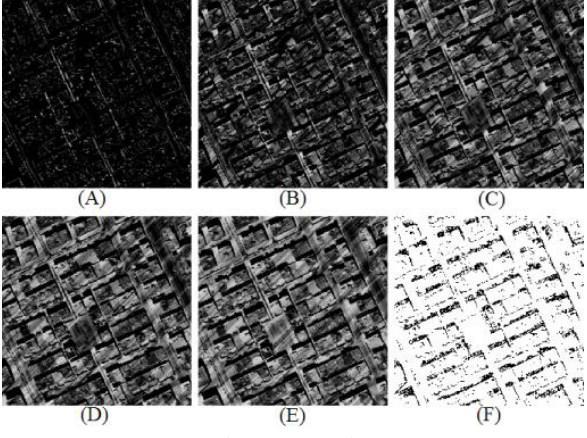
Figure 1. Subtraction of main image from reconstructed image by a SE with 45 degree direction and a scale of, A. 5×5, B.